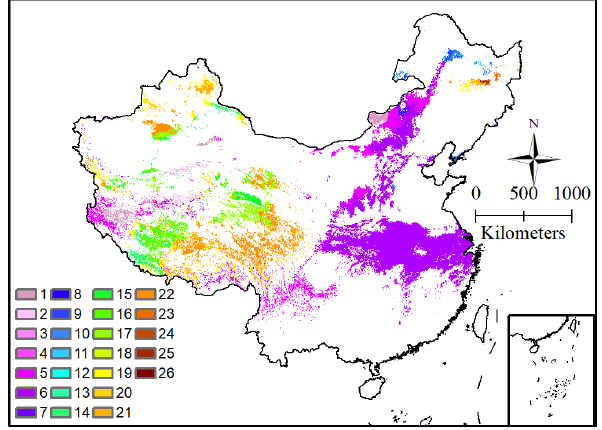
Figure 15. Trends of the annual snowmelt, precipitation, snowfall and air temperature based on the Mann–Kendall method in China during the 1951–2017 period. The meanings of the numbers in the legend are shown in Table